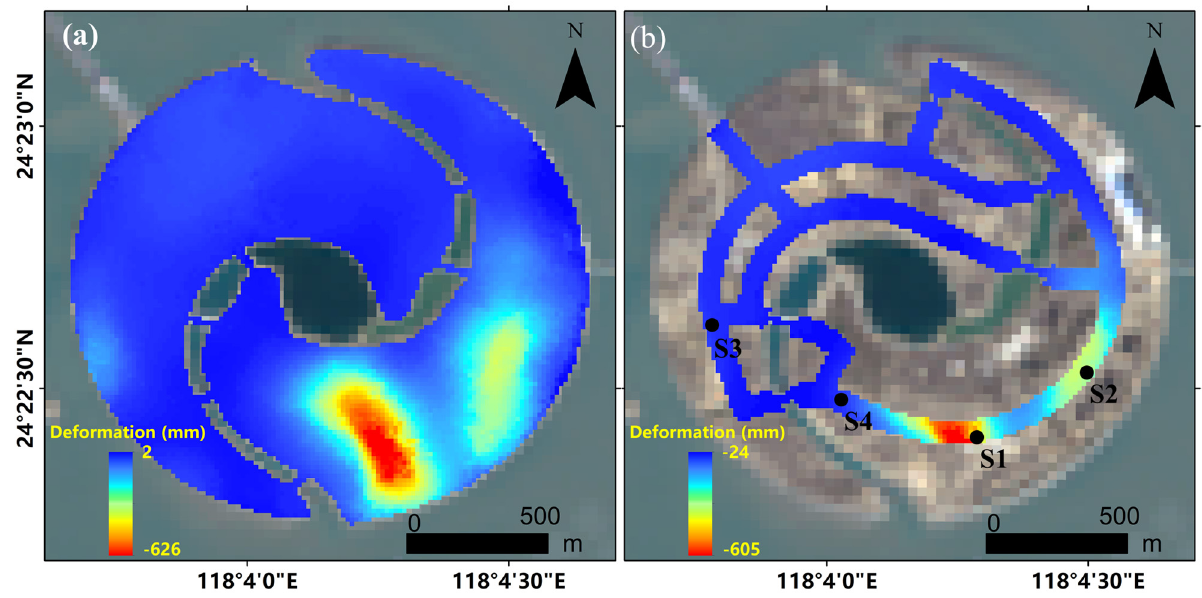
Figure 8. ( a ) Cumulative vertical deformation map of Shuangyu Island, and ( b ) of the roads in Shuangyu Island, where S1–S4 are the locations for deformation time series analysis in Figure 9.